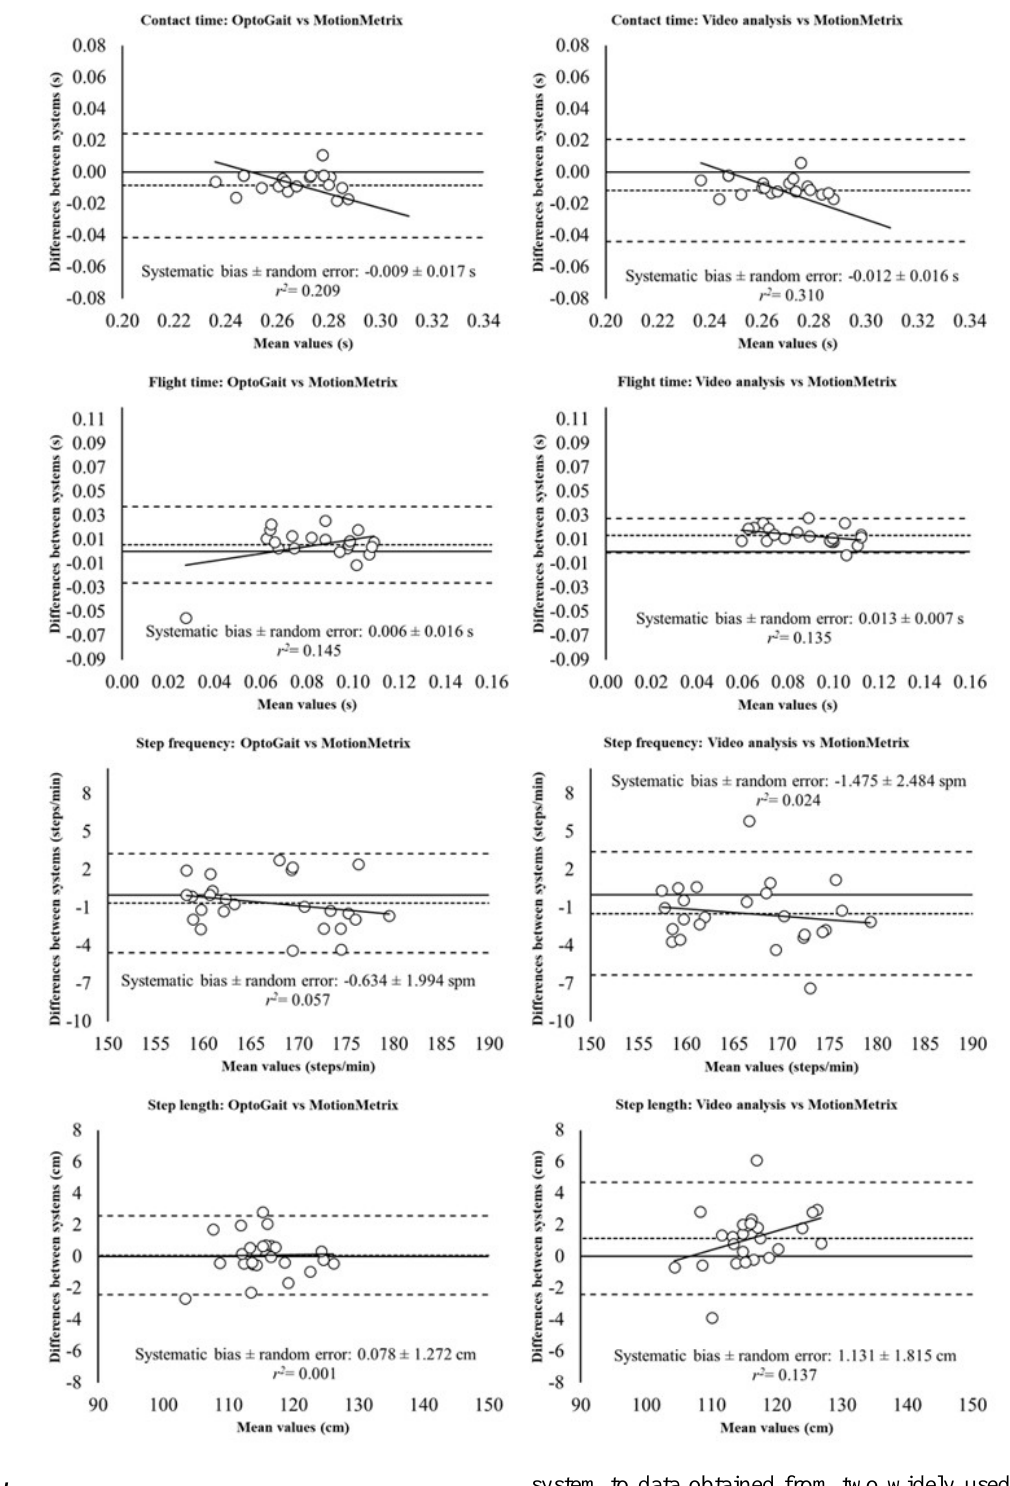
Figure 1. Bland-Altman plots for the measurement of spatiotemporal parameters (ie, from up to bottom: contact time, flight time, step frequency, and step length) during running at a comfortable speed obtained from Kinect with MotionMetrix software and two different systems (OptoGait and high-speed video analysis at 1000 Hz). The plot includes the mean difference (dotted line) and 95% limits of agreement (dashed line), along with the regression line (solid